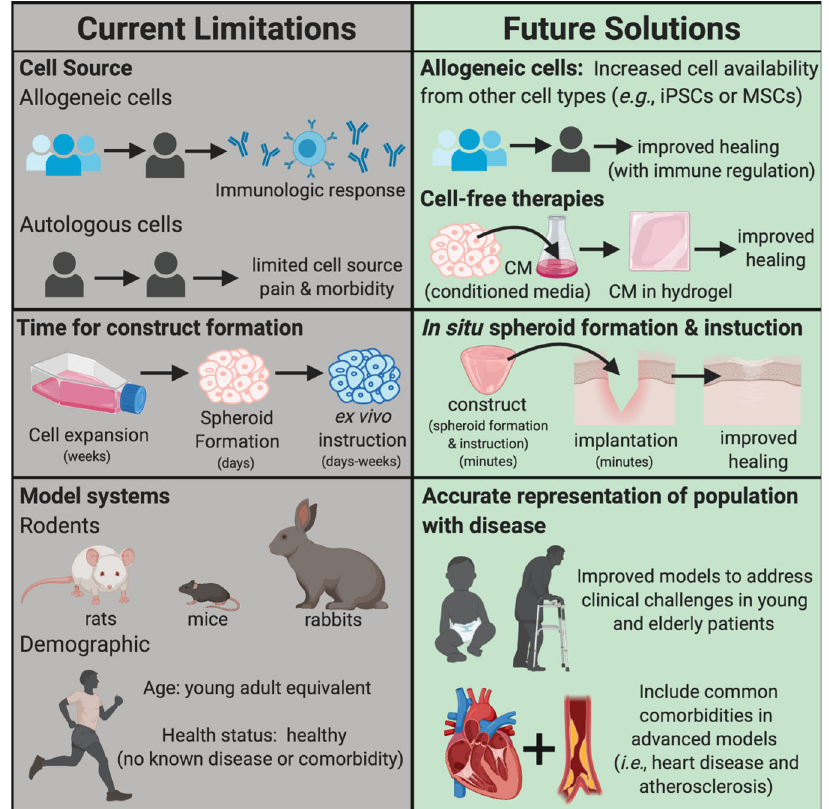
Fig. 2 Schematic image illustrates the limitations and future solutions for spheroid use in therapeutic applications. Current limitations to clinical spheroid use include reliable and safe cell sources, temporal factors in the generation, and translation between model systems and human